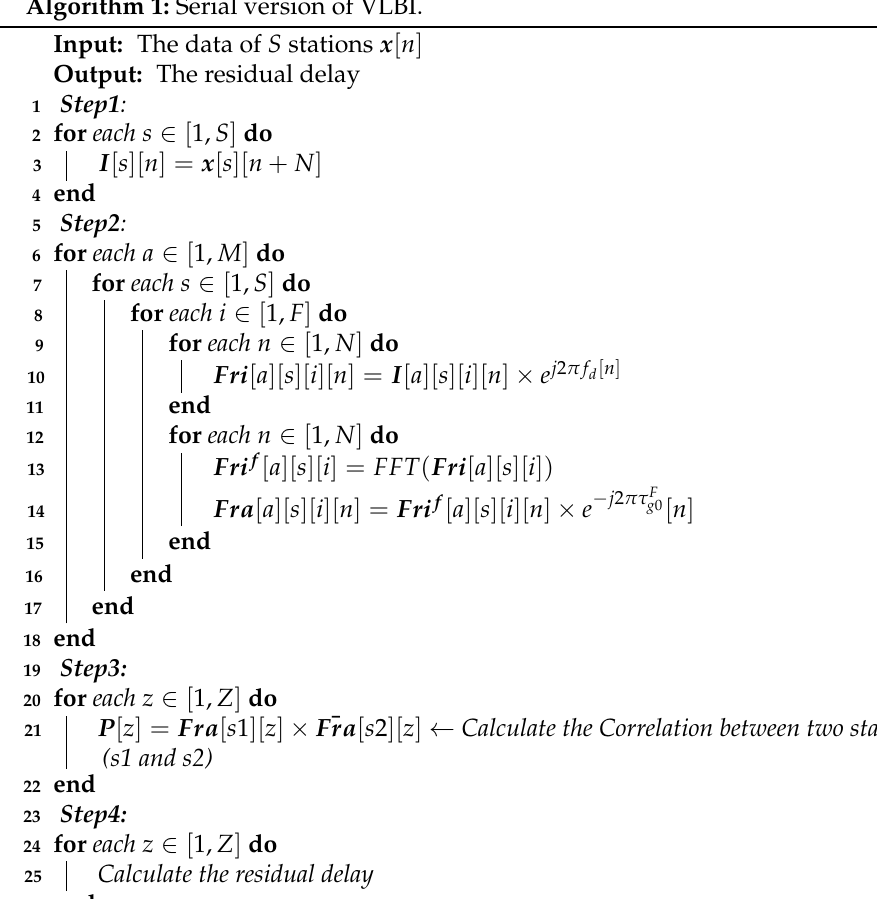
Algorithm 1: Serial version of